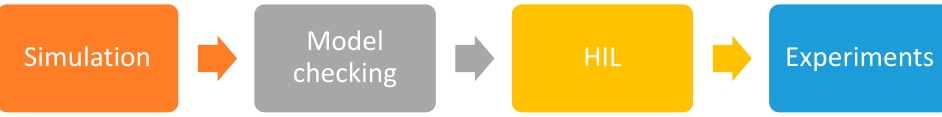
Figure 11. Verification workflow of the control algorithm.